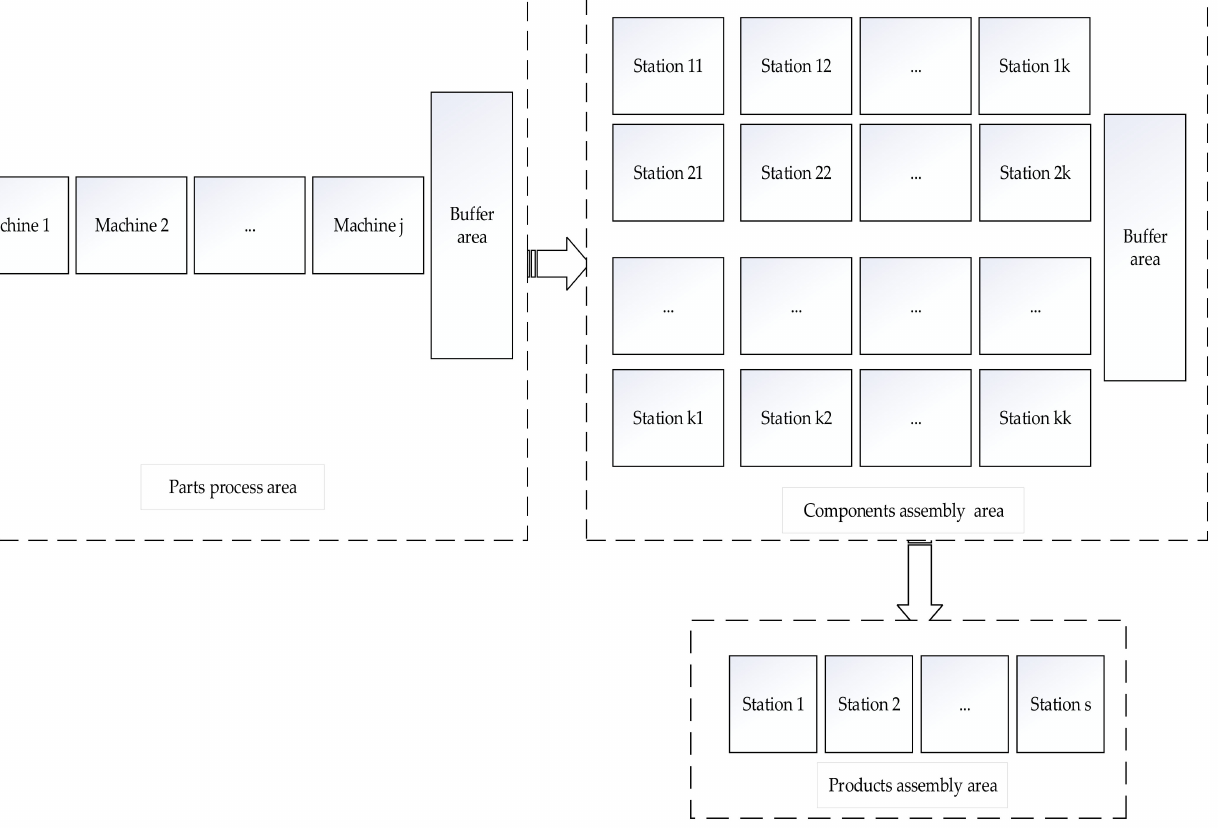
Figure 1. Hybrid mixed-flow